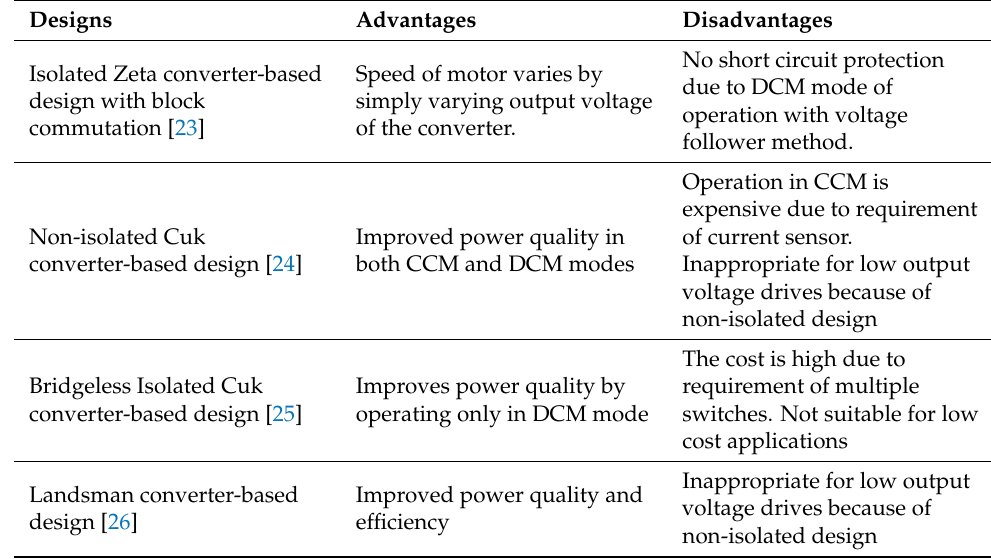
Table 2. Techniques of BLDC motor driver supply and control design as per the recent